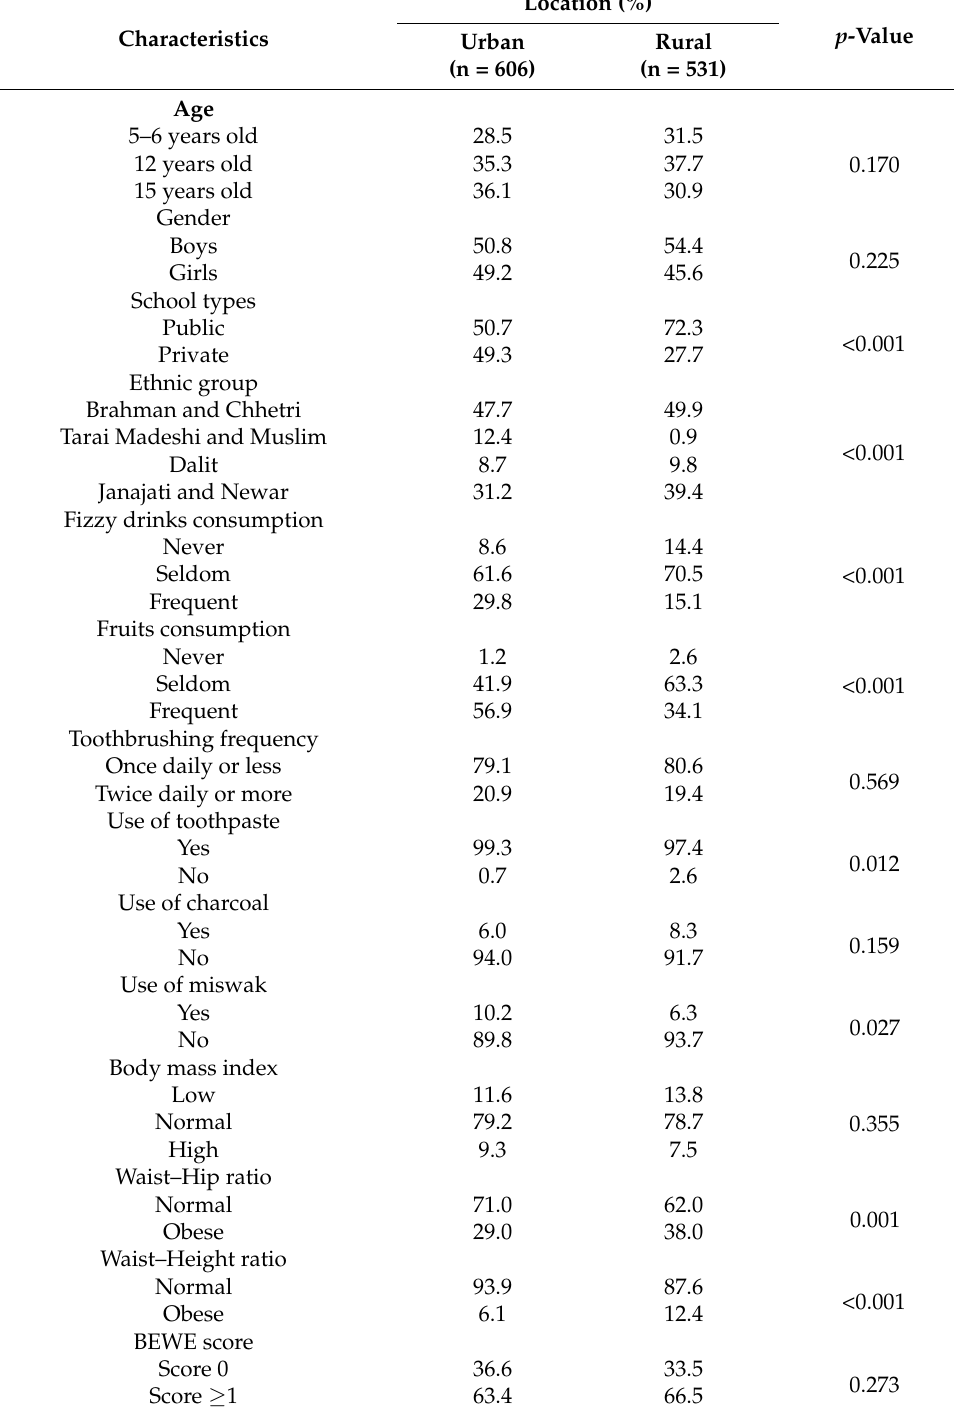
Table 1. Distribution (%) of the participants according to their location of residence stratified by age, gender, school type, ethnic group, fizzy drinks consumption, fruits consumption, toothbrushing frequency, use of toothpaste, use of charcoal, use of miswak, body mass index, waist–hip ratio, waist–height ratio and BEWE